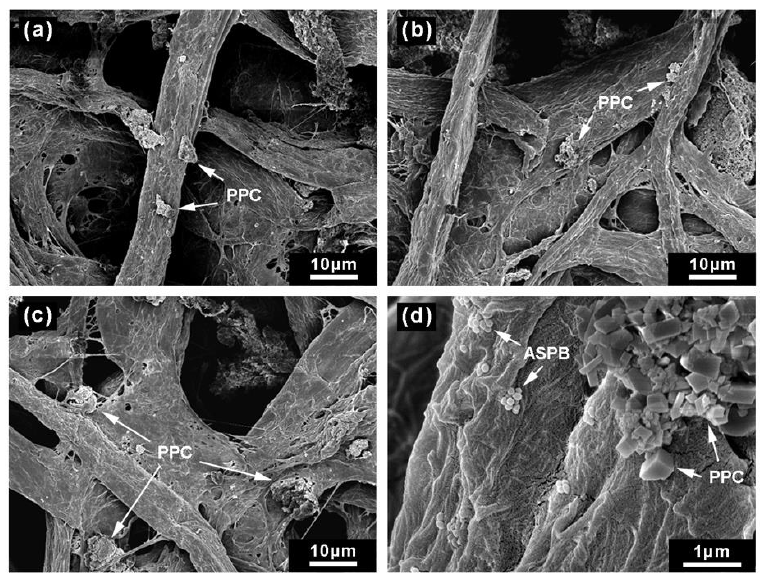
Figure 9. Morphology of flocs from pulp suspensions ( a ) with no additives, ( b ) with CPAM/CS, ( c ) and ( d ) with CPAM/ASPB.